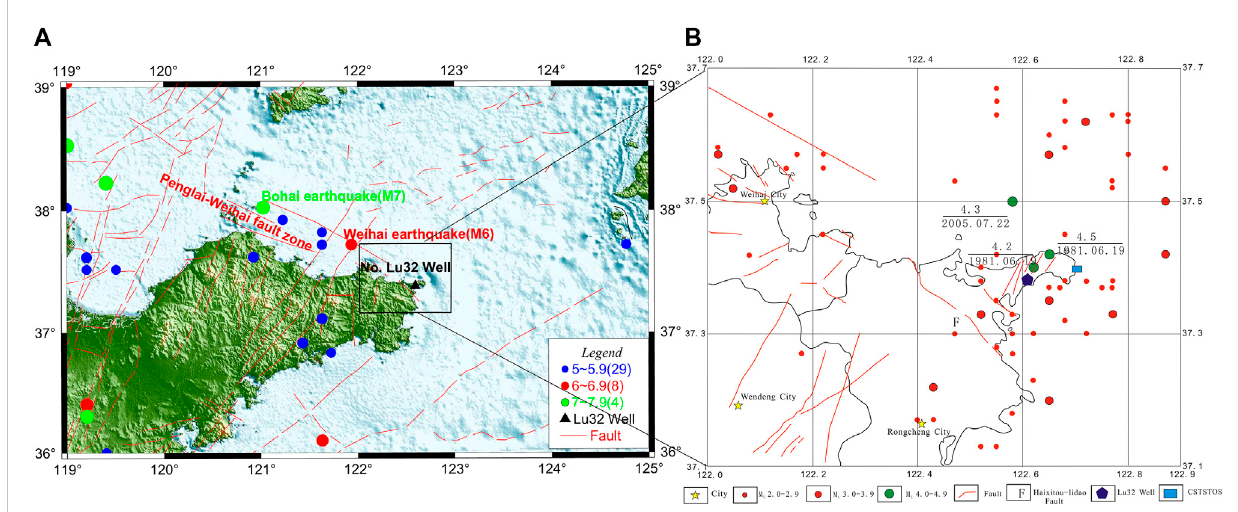
FIGURE 1 Seismotectonic settings of the No. Lu 32 well in the Jiaodong Peninsula, China. (A) Geological setting; (B) regional location [CSTSTOS is the Chengshantou seawater temperature observation station, and fault information and earthquake information are revised from (Chao et al.,